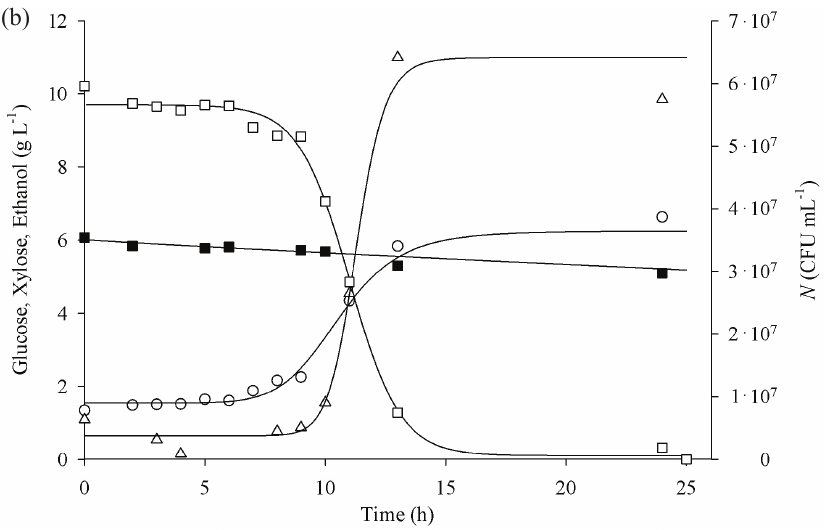
Fig. 8 – Changes in glucose (□), xylose (  ), ethanol (○), and cell number (N, ∆) con - centrations during anaerobic cultivation of genetically engineered S. cerevisiae on liquor wheat straw hydrolysate media obtained at 180 °C/5 min/2.0 % w/w H